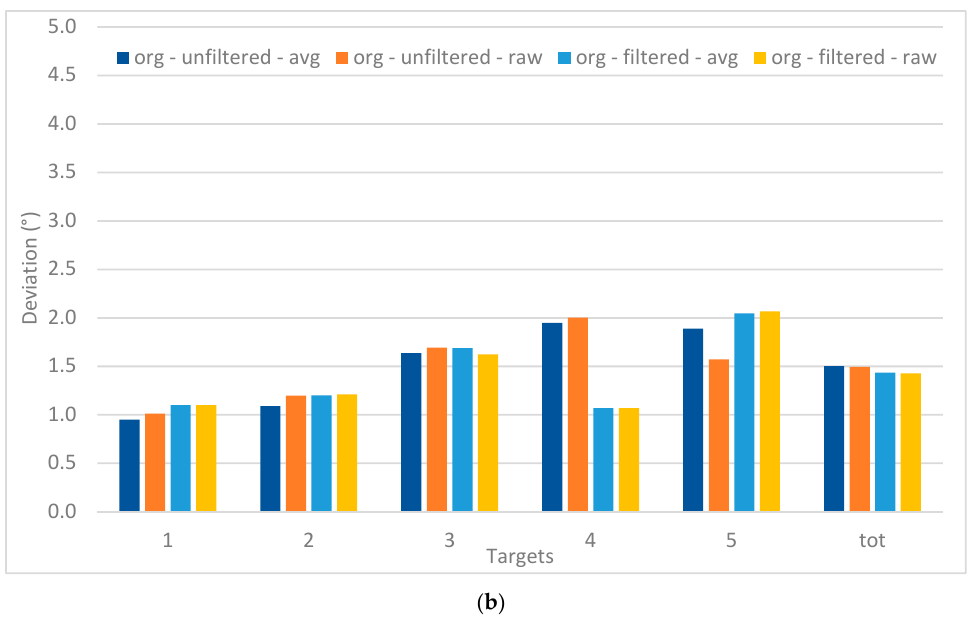
Figure 10. Deviations of the registered data (13 points ( a ); 5 points ( b )), comparing filtering and the raw versus avg recordings (in °). Table 4. Univariate ANOVA test on the recorded